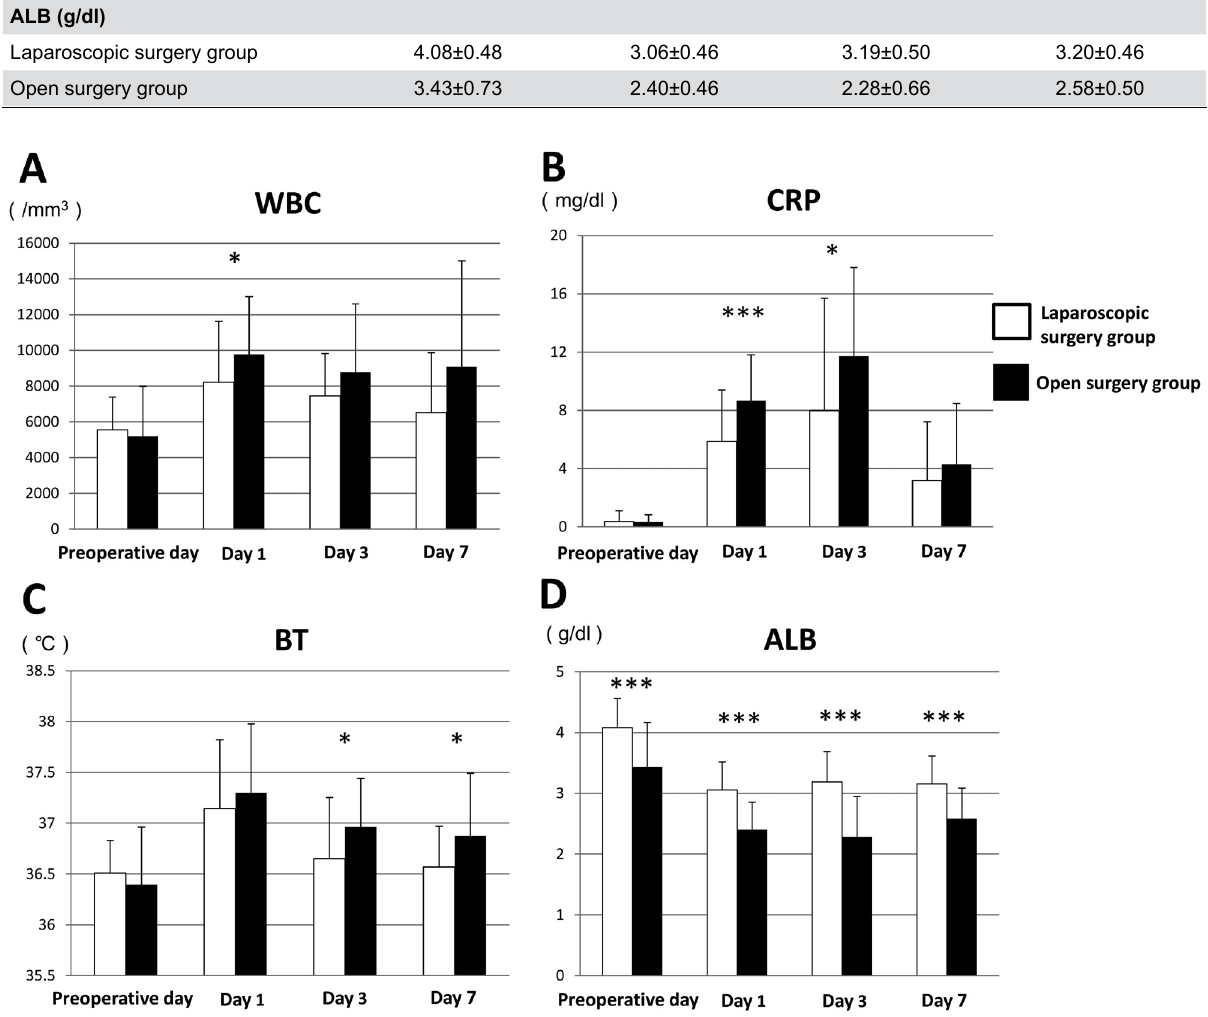
Figure 1- Changes in (A) WBC count, (B) CRP level, (C) BT, and (D) ALB in laparoscopic surgery and open surgery groups. Error bars represent the mean±SD. There were statistically significant differences between the groups. *p<0.05,